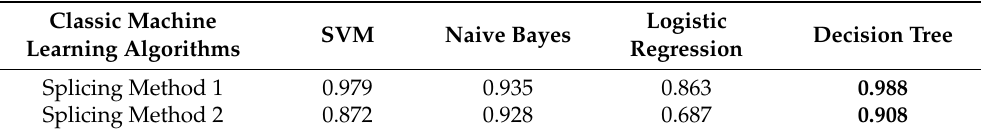
Table 5. Comparison of the classification effects using different splicing methods and different secondary classifiers.